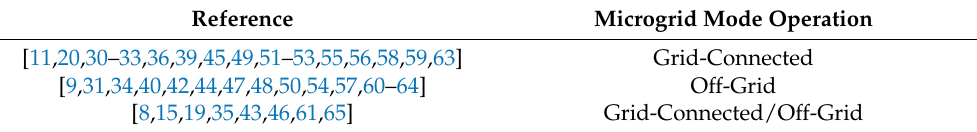
Table 3. Modes of microgrids operating.